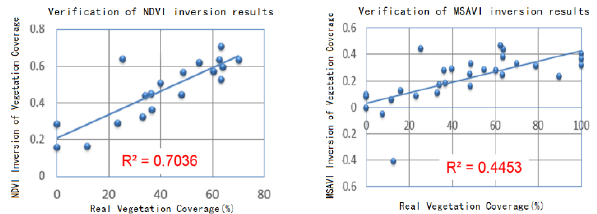
Figure 5. Comparison of vegetation coverage using NDVI and MSAVI